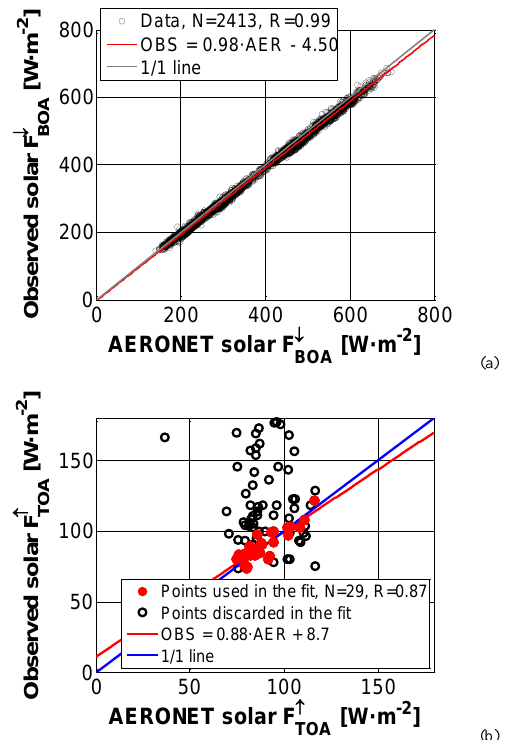
Figure 11. (a) Observed SolRad-Net level 1.5 vs. modeled AERONET level 2.0 instantaneous solar downward fluxes at the ↓ ) in Barcelona over the pe- bottom of the atmosphere (BOA, F BOA riod May 2009–October 2014. (b) Observed CERES vs. modeled AERONET level 1.5 instantaneous solar upward fluxes at the top ↑ ) for all three station: Ersa data are of the atmosphere (TOA, F TOA from 2008 to 2014, Palma data from 2011 to 2014 and Alborán data from 2011 to 2012. The maximum time difference allowed between observed and AERONET fluxes is ± 1 and ± 15min at the BOA and TOA, respectively. In (b) the pairs (CERES, AERONET) consid- ered in the fit (red solid bullet) are selected for cloud fraction <5% and shortwave upward radiance<50Wm − 2 sr − 1 (see text for ex- planations); the open bullets represent the pairs discarded in the fit but shown for